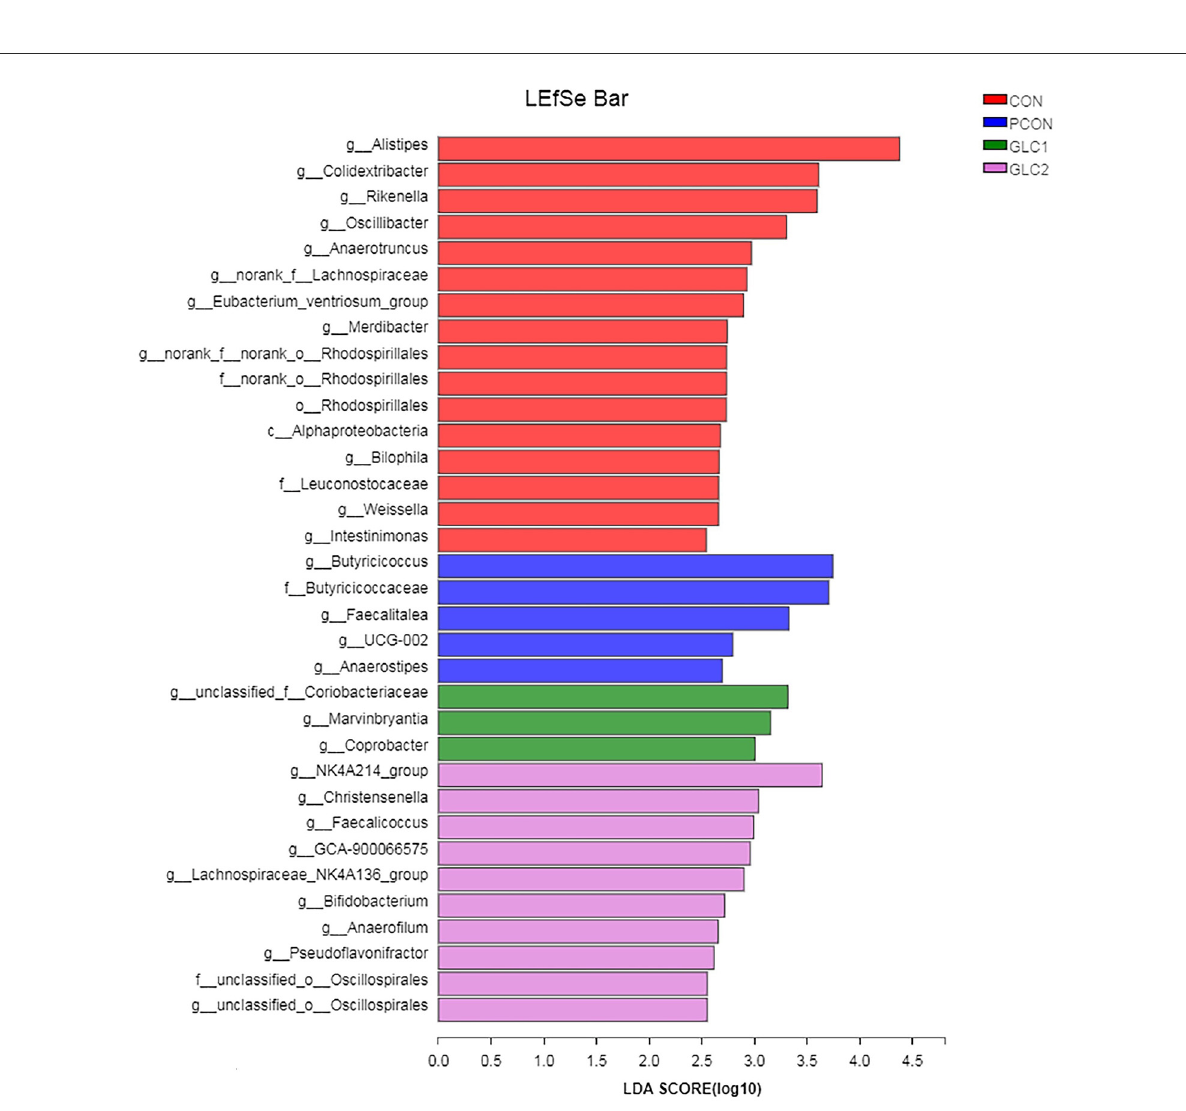
FrontiersinVeterinaryScience